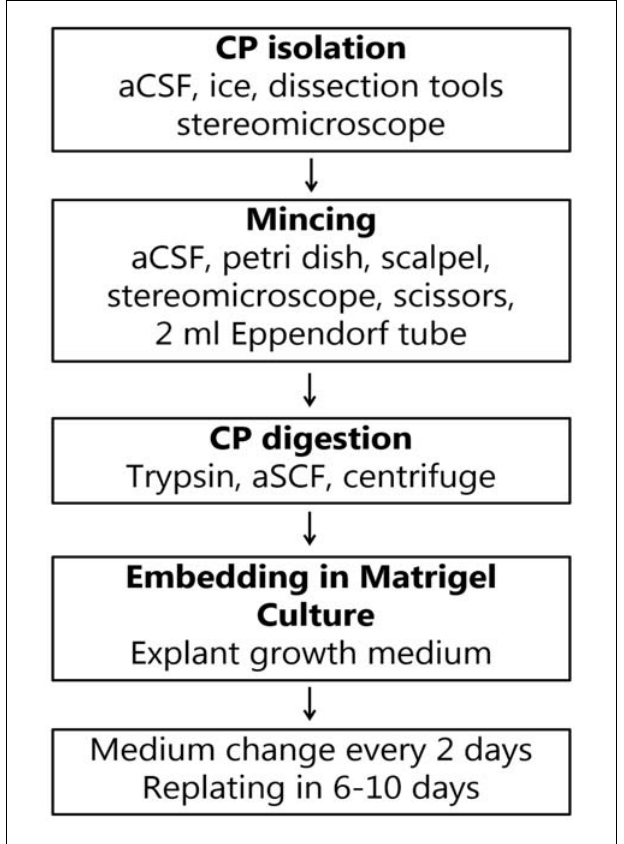
FIGURE 2 | Flow chart for the generation of CP